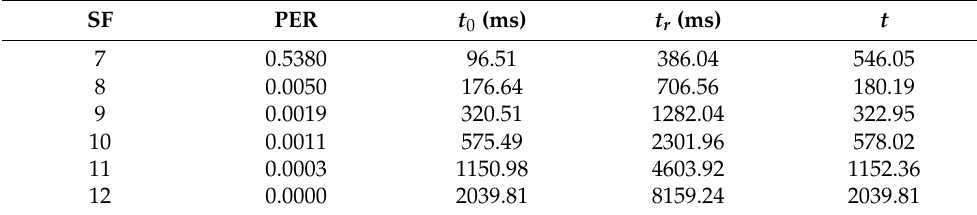
Figure 12. Transmission time t for different SNR and SF settings. The lower the (t), the better. Table 2. Given some parameters, the result of the transmission time t with different SF